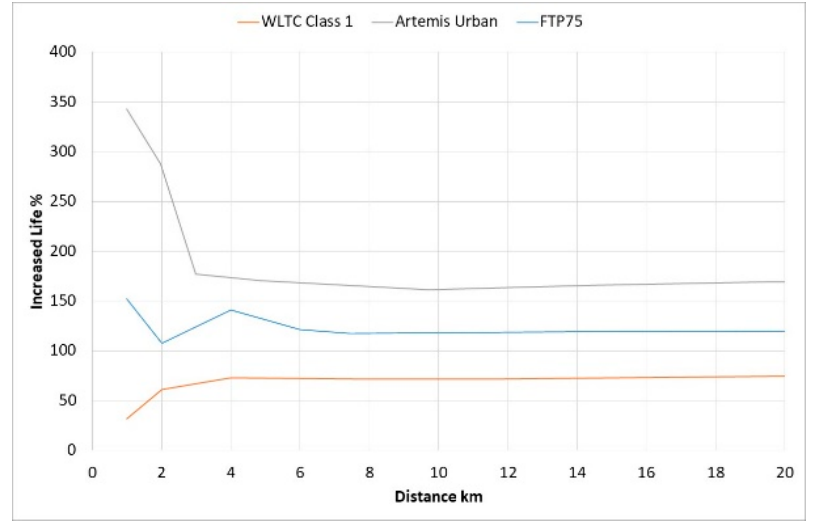
Figure 17. Increased life% with varying the mission distance for different driving cycles.